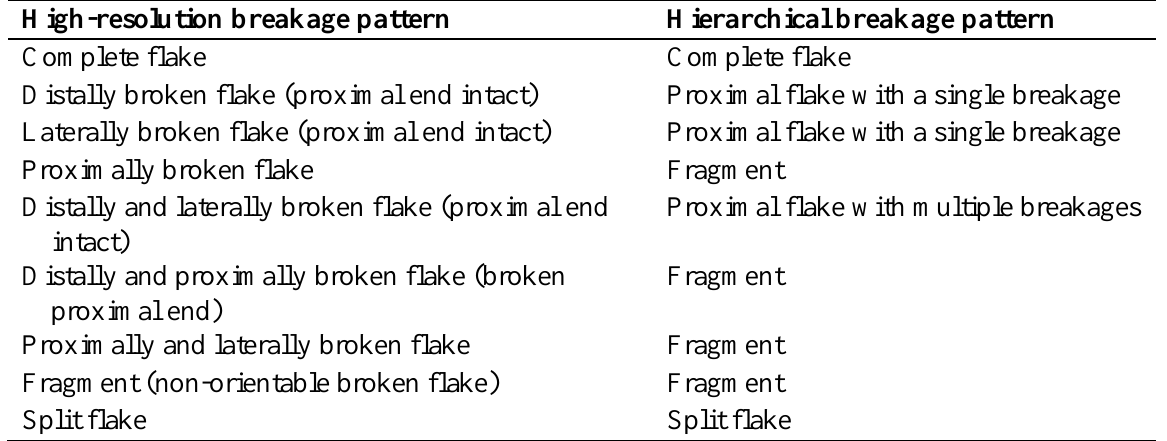
Table 2. Conversion terminology for the two methods for classification of